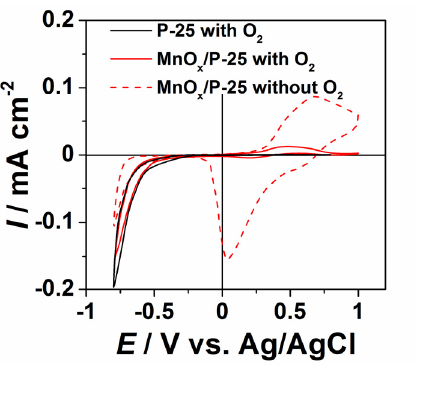
Figure 5. Cyclic voltammograms (CV) curves for mesoporous P-25 film-coated (FTO) electrodes with MnO fluorine-doped SnO 2 presence of O 2